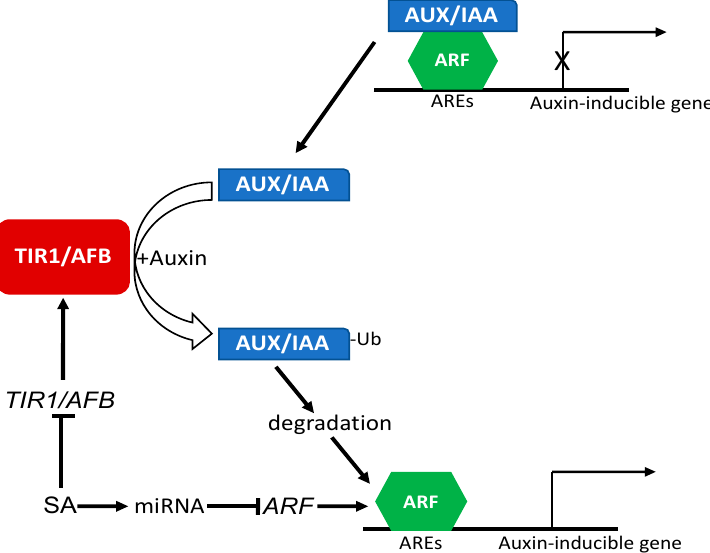
Figure 4. Regulation of auxin signaling and response by SA. In the absence of auxin, auxin-inducible genes are repressed by AUX/IAA repressors through interaction with ARF transcription factors. When auxin levels increase, auxin binds to the TIR1/AFB auxin receptor complexes to promote their binding of AUX/IAA repressors and targets their ubiquitination and degradation. Degradation of AUX/IAA repressors leads to derepressing ARF-dependent transcription of auxin-regulated genes. SA represses the expression of auxin TIR1/AFB auxin receptor genes. SA is also dependent on targeting of ARF genes by microRNAs such as